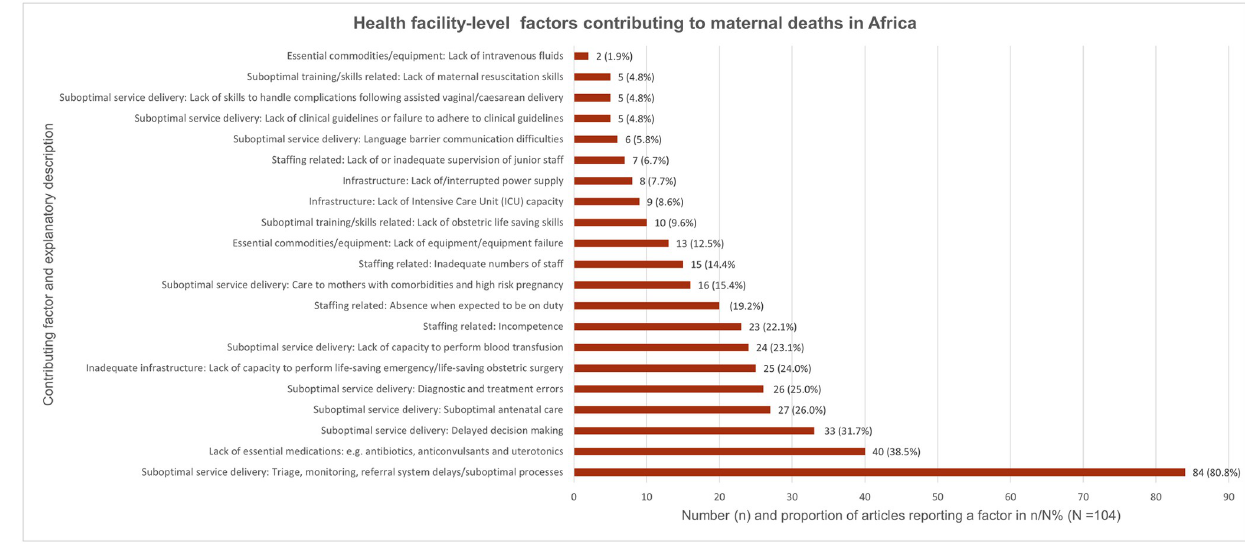
Fig 4. Health-Facility level factors contributing to maternal deaths in